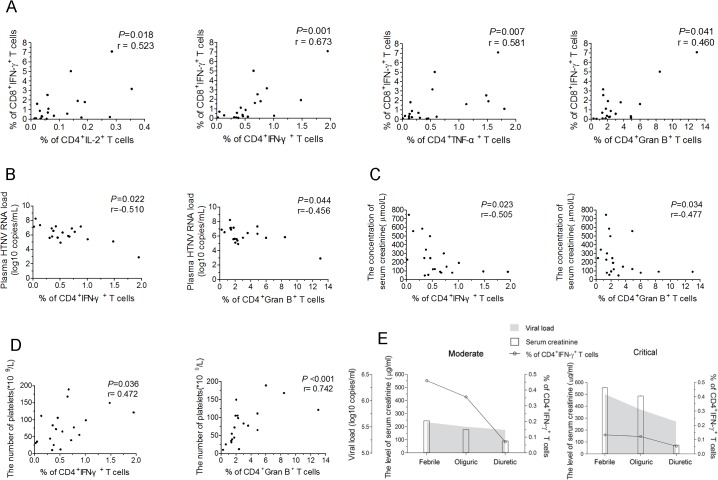
The correlations of HTNV-Gn/Gc-specific CD4+T-cell responses with CD8+T-cell immunity, viremia and clinical parameters.(A) Analysis ofthe correlations between the frequency of CD4+IL-2+T cells, CD4+IFN-γ+T cells, CD4+TNF-α+T cells, or CD4+granzyme B+T cells (x axis) and the percentage of CD8+IFN-γ+T cells (y axis) during the acute stage of HFRS. (B-D) Analysis of the relationship between the percentage of IFN-γ or granzyme B-producing CD4+T cells and the plasma HTNV RNA load (B), the serum creatinine levels (C), or platelets numbers (D) during acute HFRS. Each spot represents a single patient. (E) Longitudinal assessment of the HTNV RNA load, serum creatinine and the frequency of HTNV-Gn/Gc-specific IFN-+CD4+T cells in representative patients with moderate severity and representative patients with critical severity during the course of the disease. The line indicates the level of IFN-+CD4+T cells, white bars indicate the serum creatinine levels, and the shaded areas show the plasma HTNV RNA load of the patients tested. The Spearman’s rank test was used for statistical evaluation. Gran B, granzyme B.